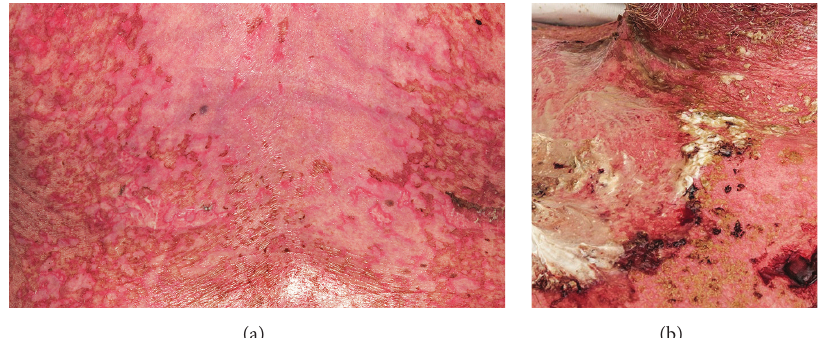
Figure 1: (a) Confluent maculopapular exanthema and bullae and skin erosions of the back. (b) Toxic epidermal necrolysis-like lesions of the anterior chest and neck with bacterial superinfection.